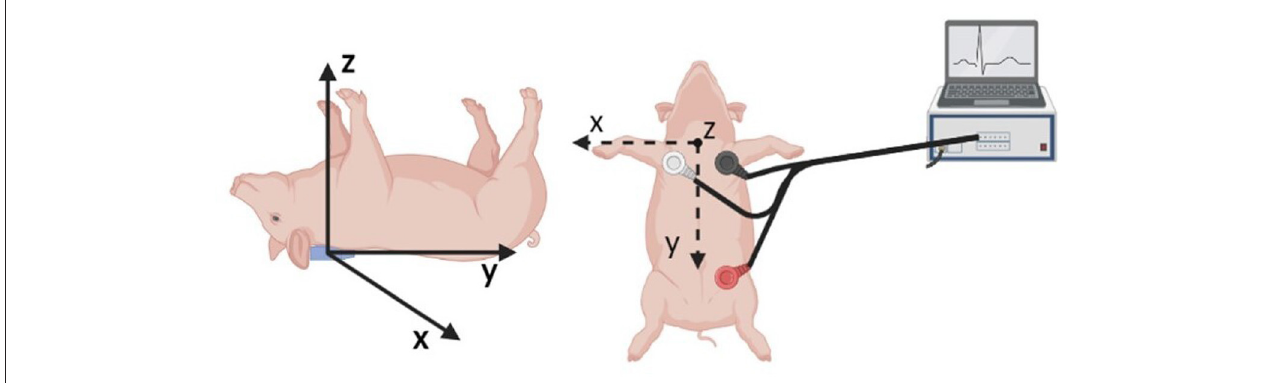
FIGURE 4 | Schematic of the sensor placement for the synchronous acquisition of ECG and BCG signals. A three axis accelerometer positioned under the swine neck with the indicated axis orientation is utilized to acquire the BCG signal (Left) . The three leads for ECG acquisition are positioned as illustrated (Right) .